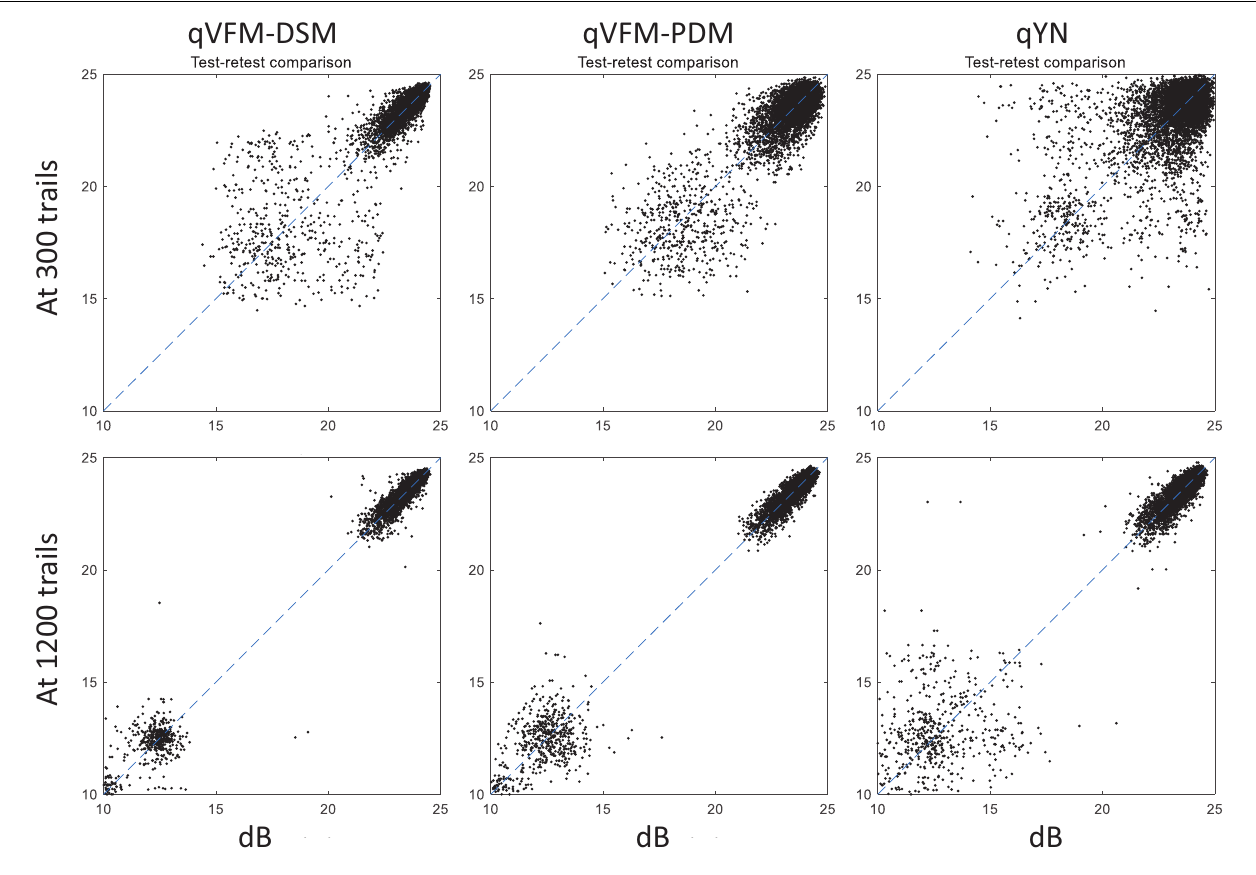
FIGURE 10 | Performance II of the qVFM-DSM, qVFM-PDM and qYN methods in estimating VFM of the simulated AMD observer. Test-retest comparison of the estimated light sensitivities from repeated 200 runs at 300 and 1,200 trials.